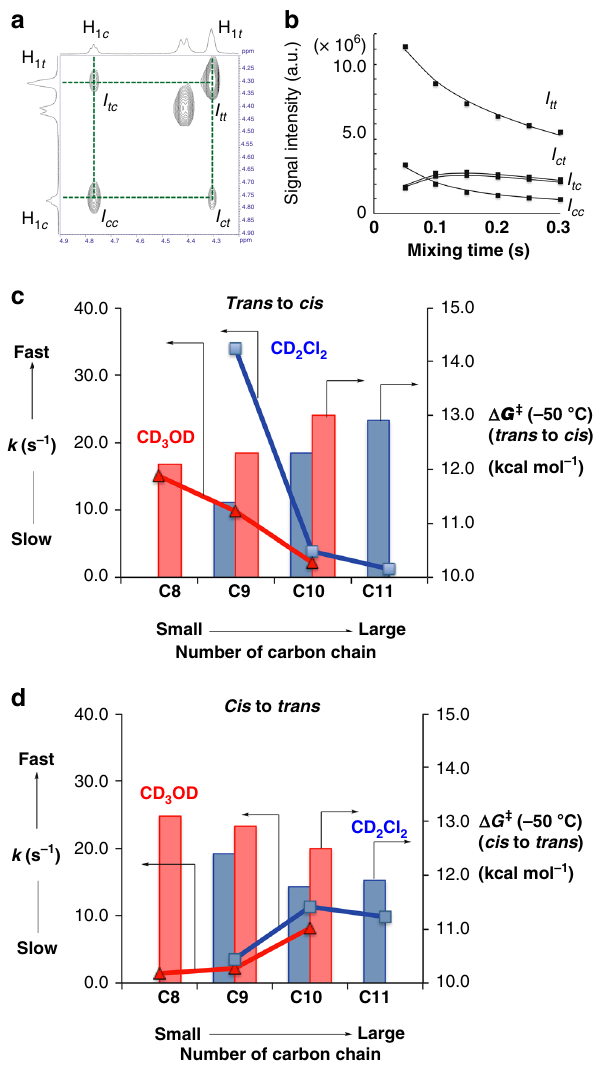
Fig. 3 Kinetic studies of lactam amide rotations. a EXSY spectrum of 18 (C10) in CD 2 Cl 2 at − 50.3 °C with a mixing time of 50 ms. b Plots of the signal intensities of 18(C10) versus the mixing time ( − 50.3 °C). Solid lines indicate the best fi t of the data to the theoretical equation. c Dependency of isomerization rate of trans to cis amide isomers on the staple length. d Dependency of isomerization rate of cis to trans amide isomers on the number of chain carbon atoms. Blue square and blue line: the rotation rate in CD 2 Cl 2 at − 50.3 °C; red triangle and red line: the rotation rate in CD 3 OD at − 42.6 °C. Blue bar: the rotation barrier ( Δ G ‡ ( − 50.0°C) ) in CD 2 Cl 2 , red bar: Δ G ‡ ( − 50.0°C) in CD 3